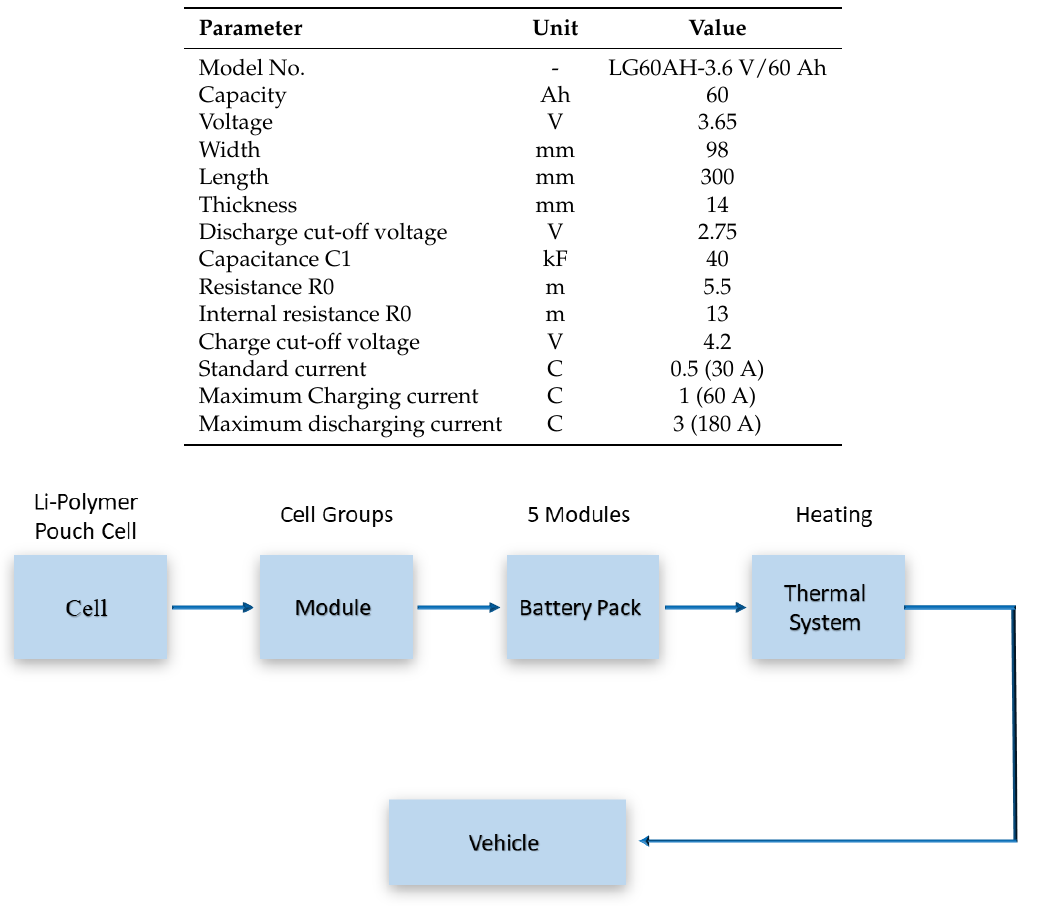
Table 2. Technical specification of a Li-ion battery.